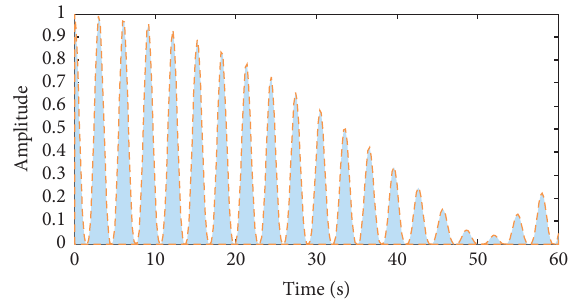
Figure 8: Time-domain waveform of singing voice after